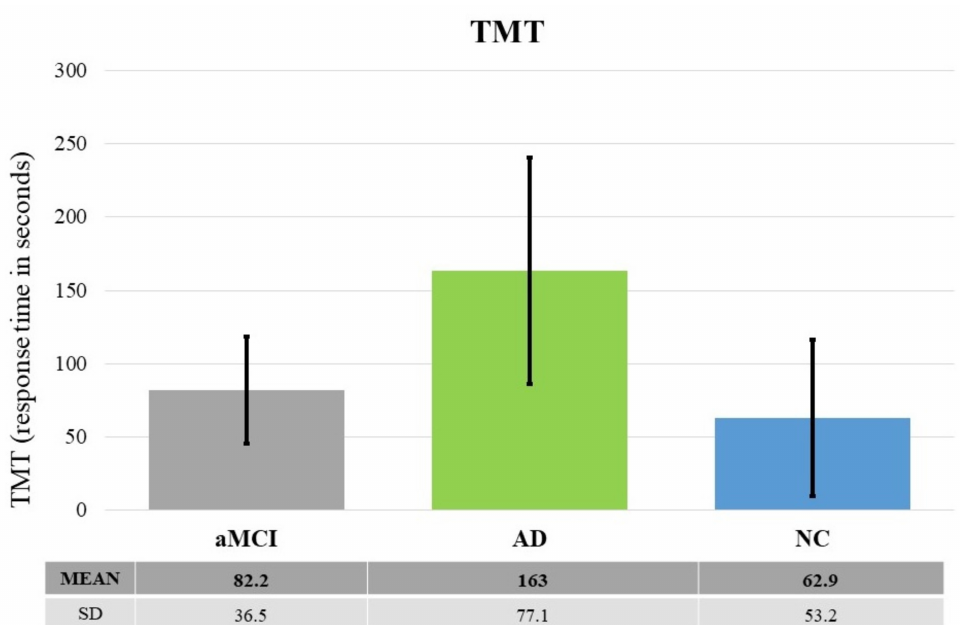
Figure 6. The graph shows the raw scores at TMT as a function of the three groups of participants (aMCI, AD and HC). The black lines represent the standard deviation. Descriptive statistics are also shown in the table below the